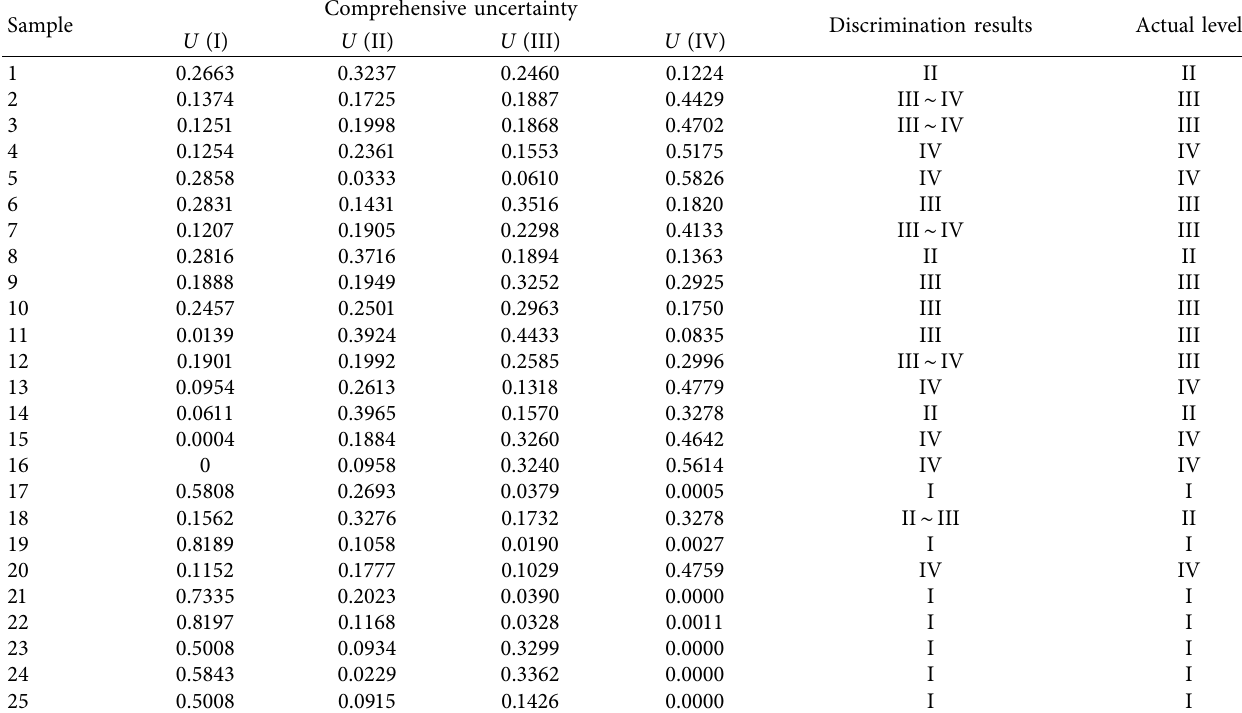
Table 6: Evaluation results of goaf stability and comparison with the actual situation.